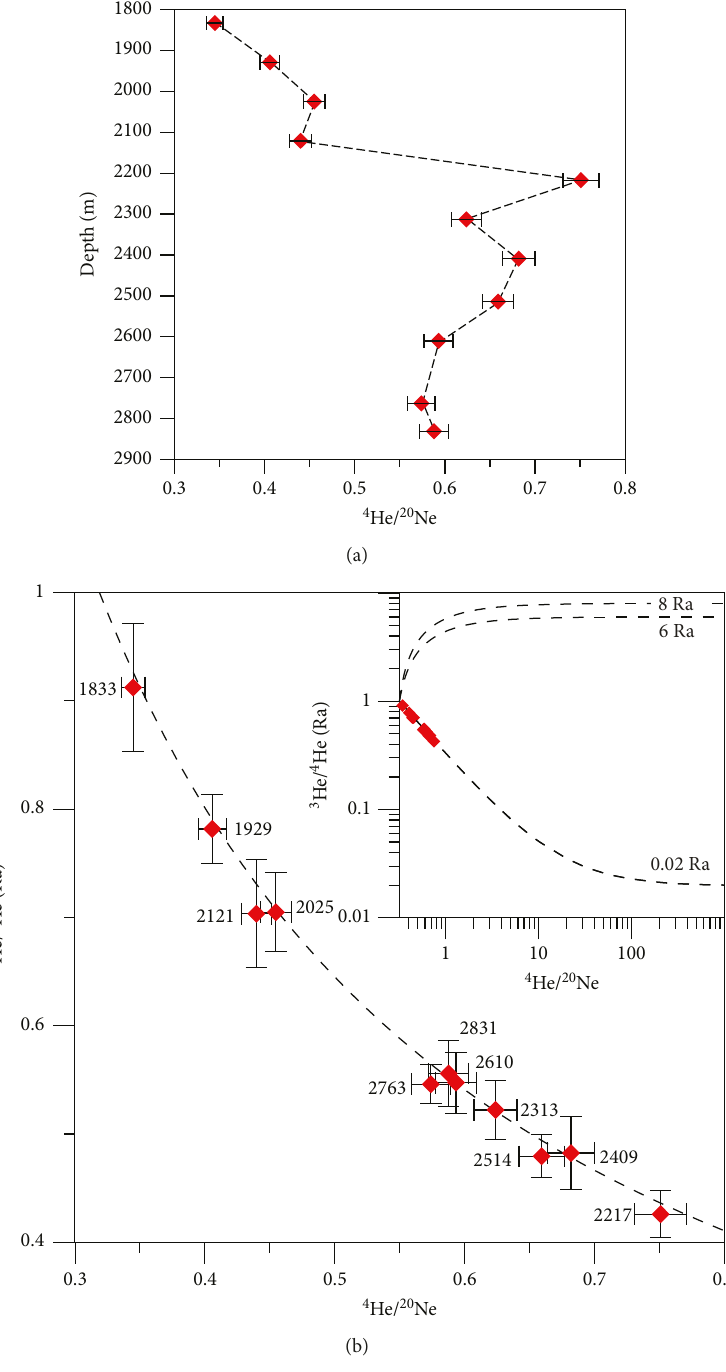
Figure 5: Plot showing (a) 4 He/ 20 Ne versus depth and (b) 4 He/ 20 Ne versus 3 He/ 4 He, obtained from isotope measurements on gas samples collected during water fl ushing after core run 7/8. Error bars indicating uncertainty in the measurement are also shown. Depth of samples in “ m ” is indicated along with data points in (b). Inset shows mixing hyperbola between air and the continental crust and two di ff erent mantle end members (6 Ra for the lithospheric and 8Ra for the asthenospheric